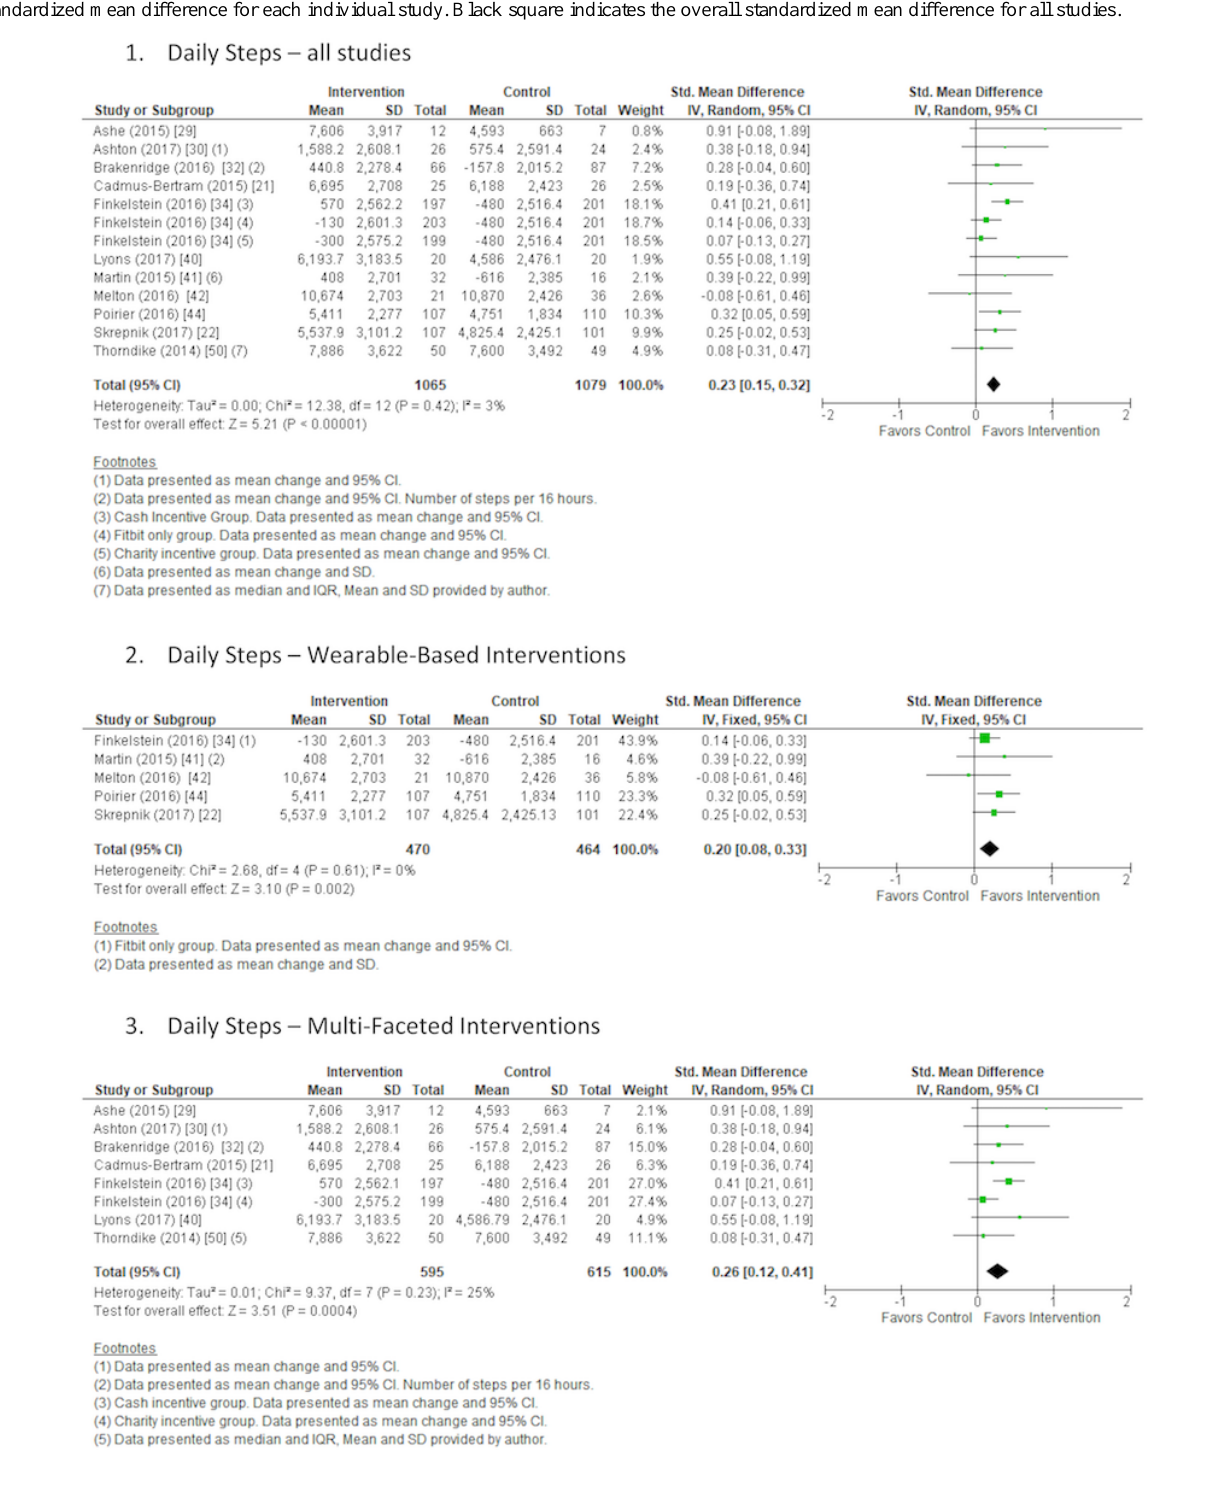
Figure 3. Forest plot of standardized mean difference of steps per day in studies comparing an intervention that included a consumer-based wearable activity tracker with a control group that did not utilize a consumer-based wearable activity tracker. Subgroup analysis was completed on studies that included wearable-based interventions compared with control and multifaceted interventions compared with control. Green square indicates the standardized mean difference for each individual study. Black square indicates the overall standardized mean difference for all